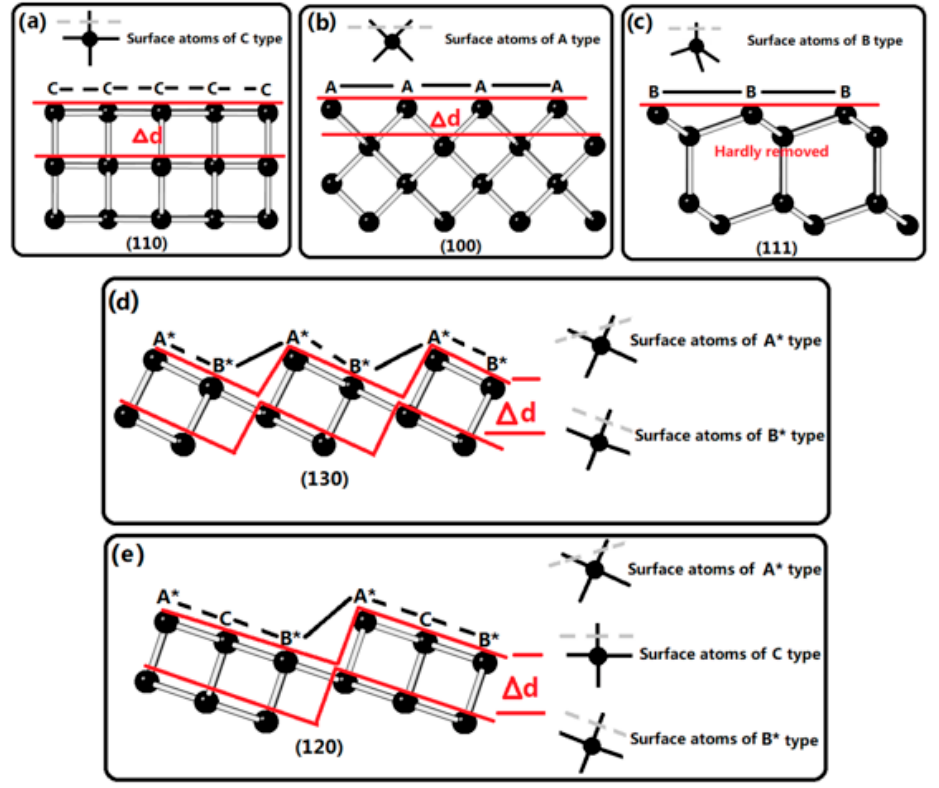
Figure 2. ( a – c ) Atomic structures and types of surface atoms of the three basic crystal planes (1 1 0), (1 0 0) and (1 1 1) of silicon; ( d , e ) atomic structures and types of surface atoms of other crystal planes (1 3 0) and (1 2 0) of silicon [29]. Surface atoms of A and B types also have A* and B* types according to their own evolution, as shown in Figure 2d,e. The difference between A type (B type) and its evolu- tion A* type (B* type) is that angles of chemical bonds are different. Thus, atomic struc- tures of other crystal planes can be regarded as composed of five types of surface atoms (A, A*, B, B* and C) through different combinations. As shown in Figure 2d,e, the combi- nation of surface atoms on the (1 3 0) plane is “A*--B*”, and the combination of surface atoms on the (1 2 0) plane is “A*--C--B*”. Therefore, by reasonably analyzing the connec- tions between surface atoms, the removal time of these different combinations of surface atoms can be estimated and etch rates of different crystal planes can be approximately gained. As shown in Table 1, errors between calculated and experimental rates are small un- der the experimental condition (the etching solution is 34 wt% KOH and the etching tem- perature is 71 °C), which verifies the effectiveness of the layer-by-layer removal model of surface atoms (Si) under KOH solution conditions. However, due to the uncertainty of the estimation of the removal time, the accuracy of this model in calculating rates of crystal planes is low in other etching solutions (for example, KOH + IPA etchant or TMAH etch- ant) [26,27]. This indicates that the application of the model has certain defects. The key to improve the accuracy of the model is to propose a specific formula for calculating the removal time of the combination of surface atoms.